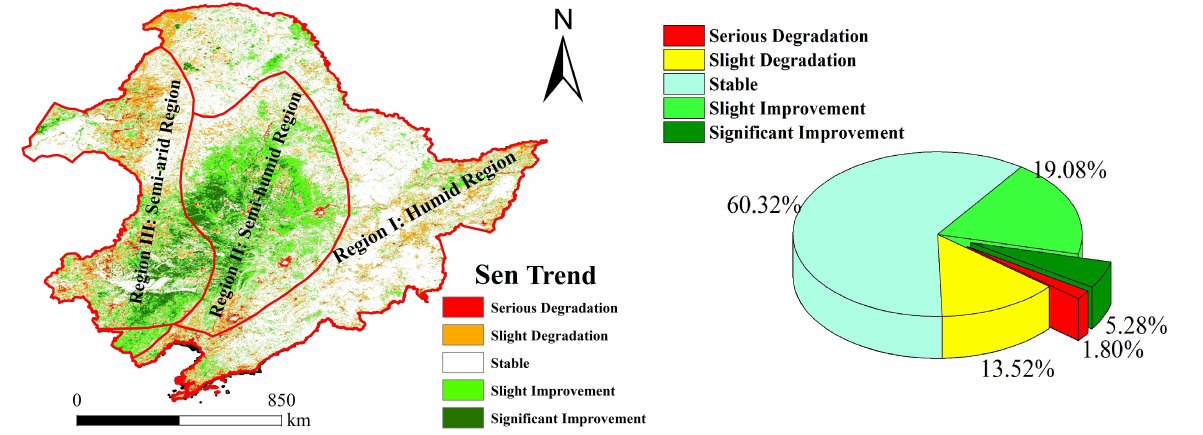
Figure 9. Distribution of vegetation cover change trends in Northeast China from 2001 to 2021 and its